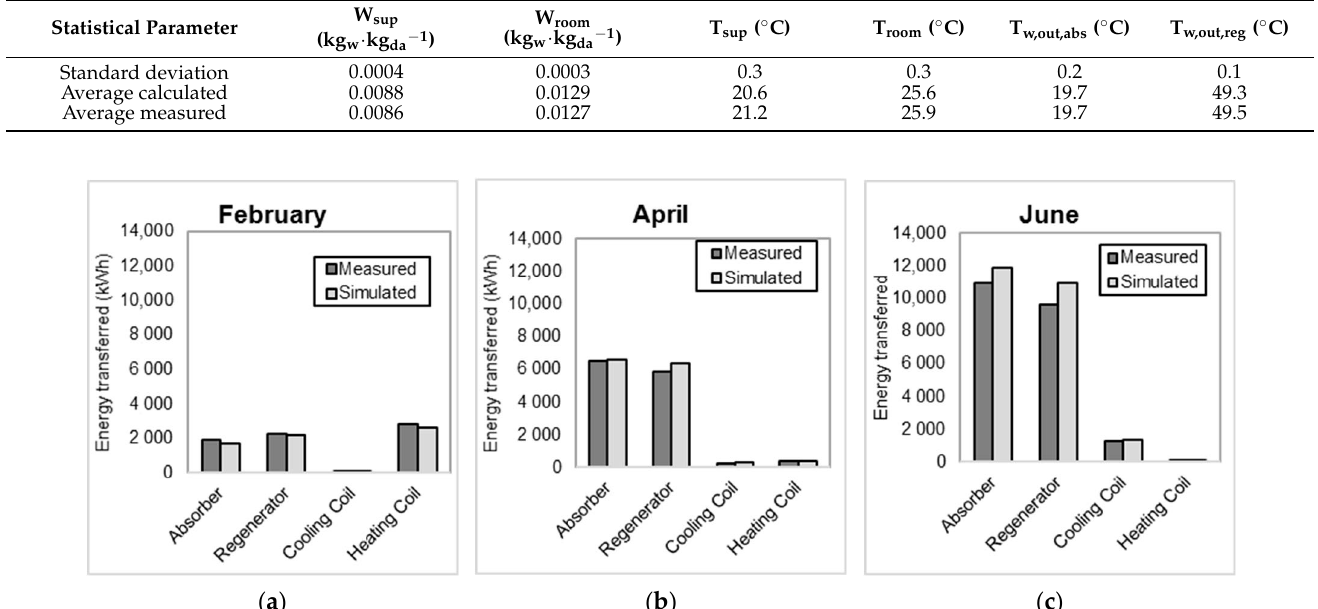
Figure 7. Comparison between calculated and measured monthly energy transferred in the main components of the system during February ( a ), April ( b ), and June ( c ). Table 6. Annual difference between the measured and calculated energy transferred.